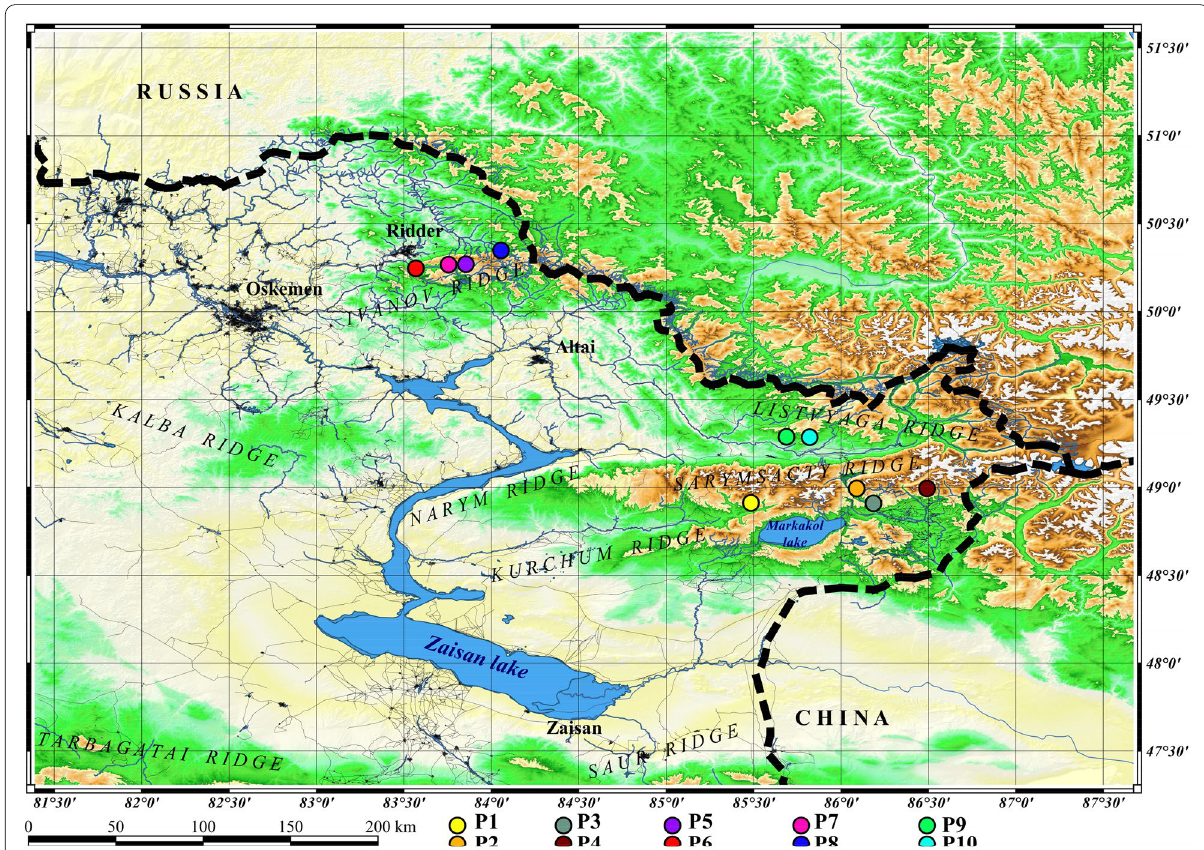
Fig. 2 Geographic locations of the studied R. rosea